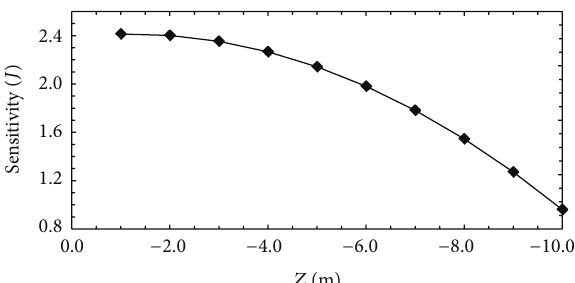
Figure 4: The modified sensitivity changes as a function of 𝑍 at 𝑋 = 0 .